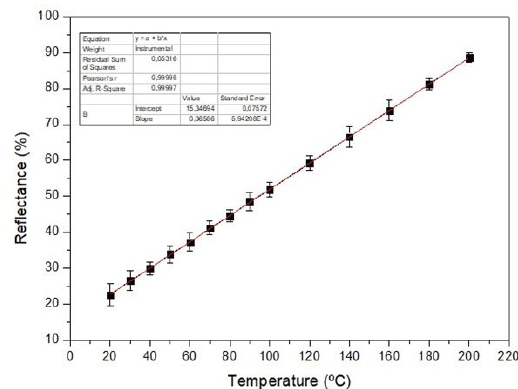
Figure 12. The relationship of reflectance signal (detected at 650 nm) of CoHo:PGLyD microspheres with temperature from room temperature (20 ºC) to 200